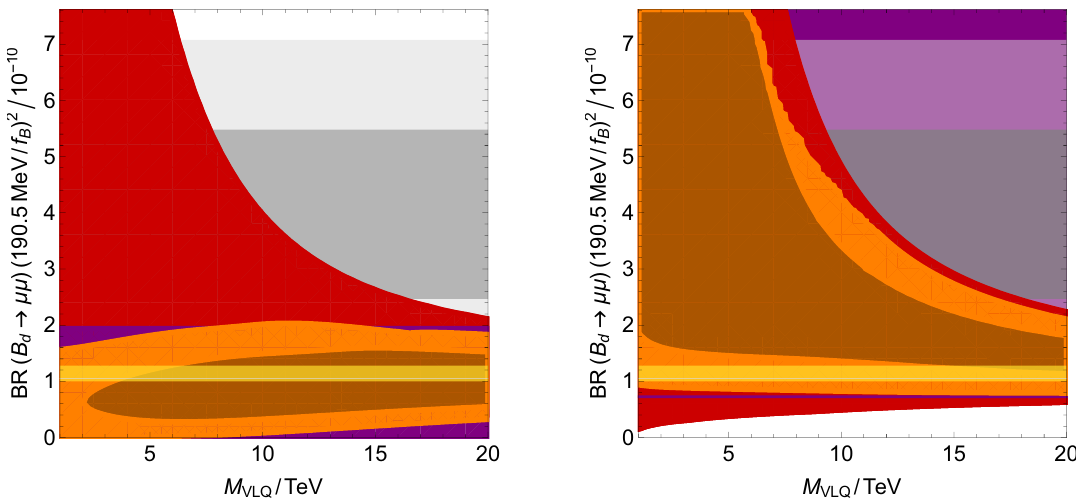
Figure 10. Predictions for Br ( B d (cid:22) (cid:22) (cid:22) ) for the LH G SM scenario D [left] and RH G SM scenario ! Q V [right], in dependence on the VLQ mass. In dark red the constraint from (cid:1) F = 2 processes j j is shown, i.e. (cid:1) M d and sin 2 (cid:12) , in purple the constraint from B + (cid:25) + (cid:22) (cid:22) (cid:22) , and in orange their ! combination. The yellow band corresponds to the SM prediction, the grey one to the measurement by the CMS and LHCb collaborations [77]. All constraints correspond to 95% CL, only inner darker bands to 68% CL.